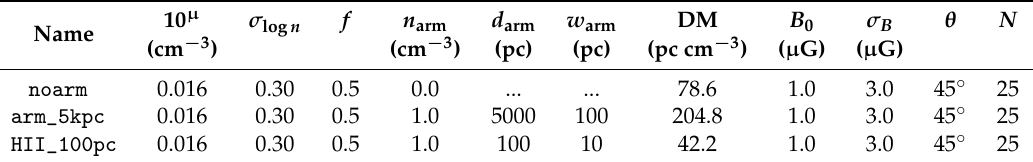
Table 1. Input parameters.